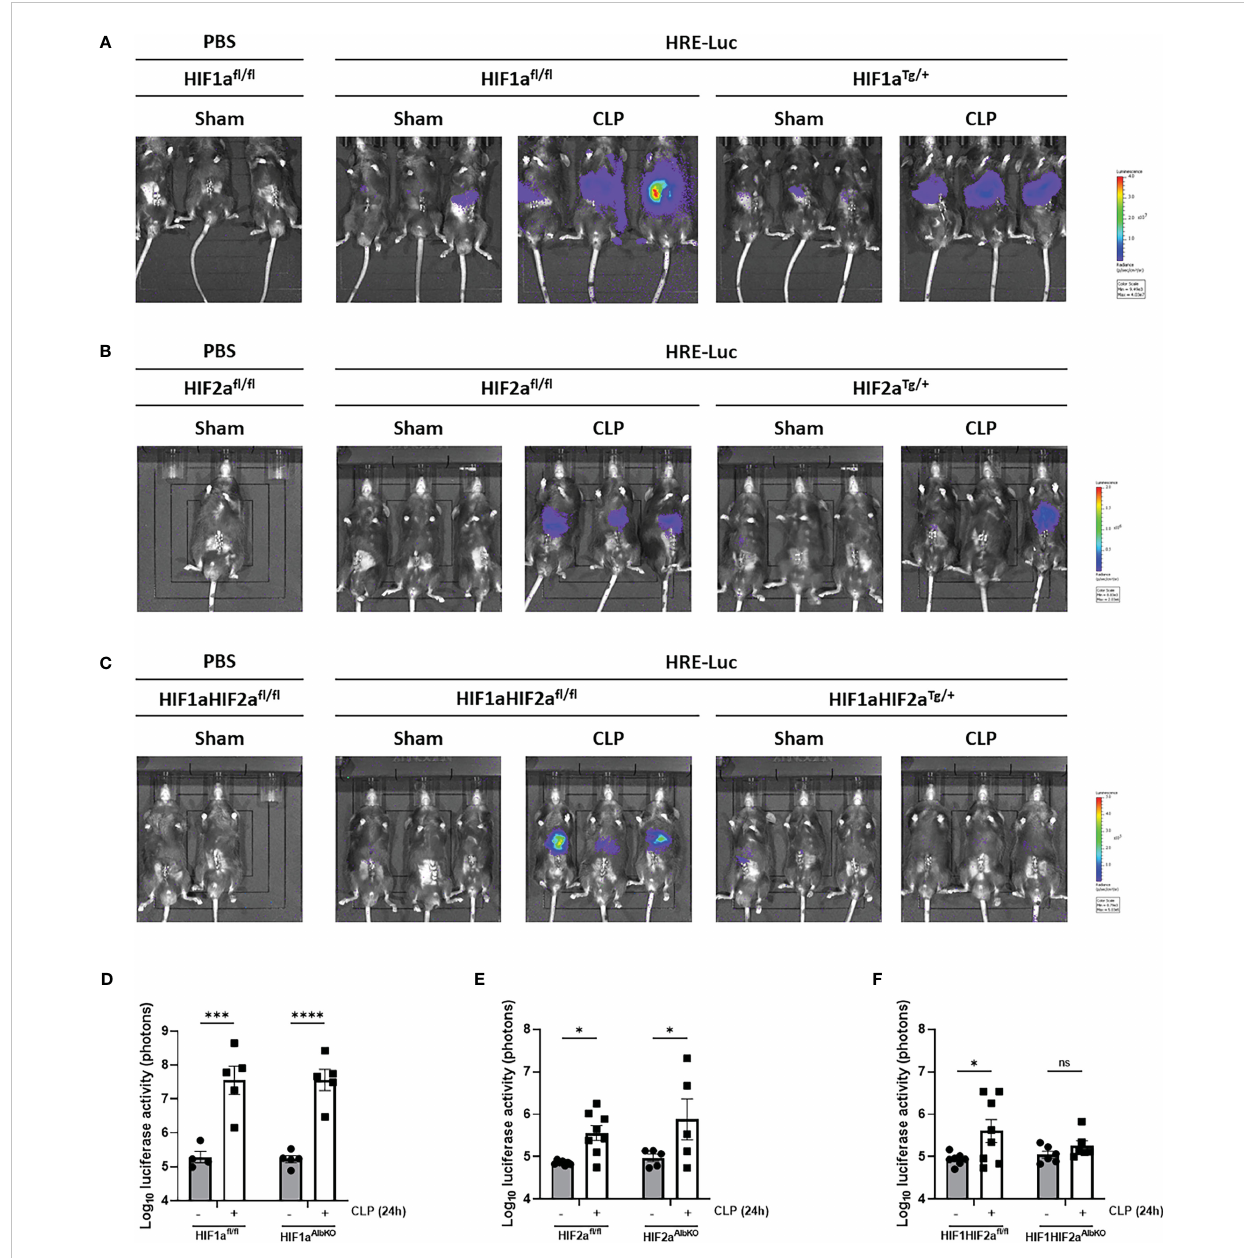
FIGURE 4 HIF activity in hepatocyte-speci fi c knock-out mice of HIF1 a and/HIF2 a in sepsis. HIF1a AlbKO , HIF2a AlbKO and HIF1aHIF2a AlbKO mice and wild-type littermates were injected with the HRE-luciferase reporter mice via high pressure injection at the tail vein. Then, mice were subjected to a sham or CLP procedure and the luciferase activity was measured 24h post-surgery. (A-C) Imaging of the luciferase activity (purple signal) of HIF1a AlbKO (A)